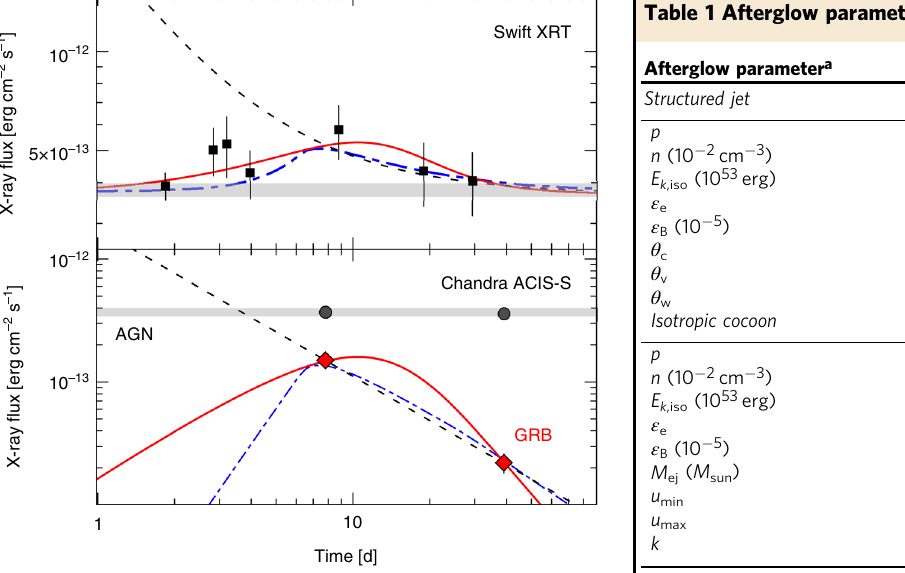
Fig. 3 X-ray observations of GRB150101B. Swift observations (top panel) found a single steady X-ray source. Chandra observations (bottom panel) revealed the presence of two nearby X-ray sources: a brighter constant source at the location of the galaxy nucleus (AGN), and a fainter variable source at the location of the GRB optical counterpart. Its X-ray behavior is consistent with a standard power-law decay (dashed line) or a rising afterglow from either an off-axis jet (solid line) or a cocoon (dot-dashed line). However, the superposition of a constant source with a power-law model violates the early Swift observations. These are instead well described by the superposition of a constant source with a late-peaking afterglow. Vertical error bars are 1 σ . The horizontal gray line shows the average fl ux level of the